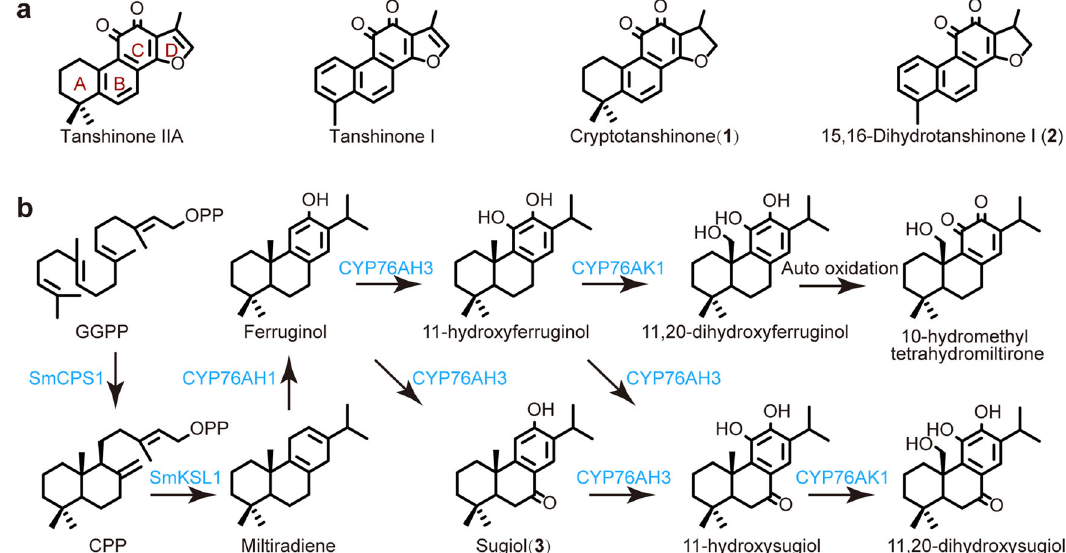
Fig. 1 Tanshinones and partial biosynthetic pathway in Danshen. a Structures of the major tanshinone constituents of Danshen: tanshinone IIA, tanshinone I, cryptotanshinone ( 1 ) and 15,16-dihydrotanshinone I ( 2 ). b Elucidated steps for tanshinone biosynthesis in